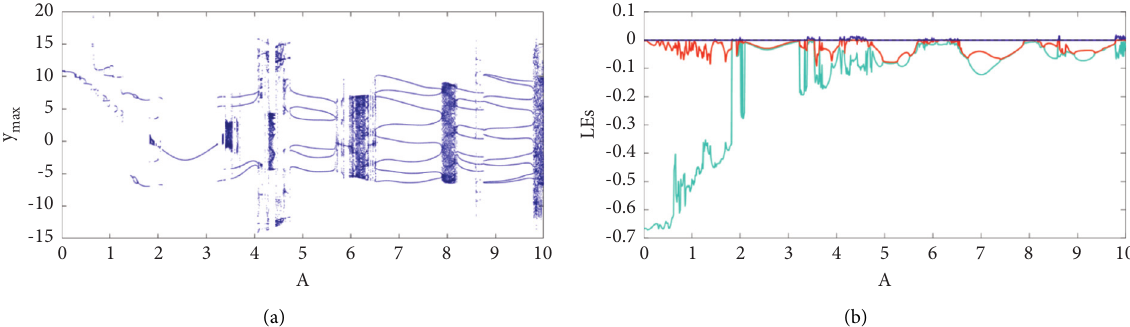
Figure 3: (a) Local maximum values of “ y ” time-series versus A in System (2) when ω � 0 . 6. The initial conditions are ( 60 , 0 ) without reinitiating. Thus, the diagram is only related to the inner limit cycle around the point ( 60 , 0 ) . (b) Corresponding Lyapunov exponent diagram. The dynamic of the system starts from a limit cycle, and then narrow areas of chaos are observed.